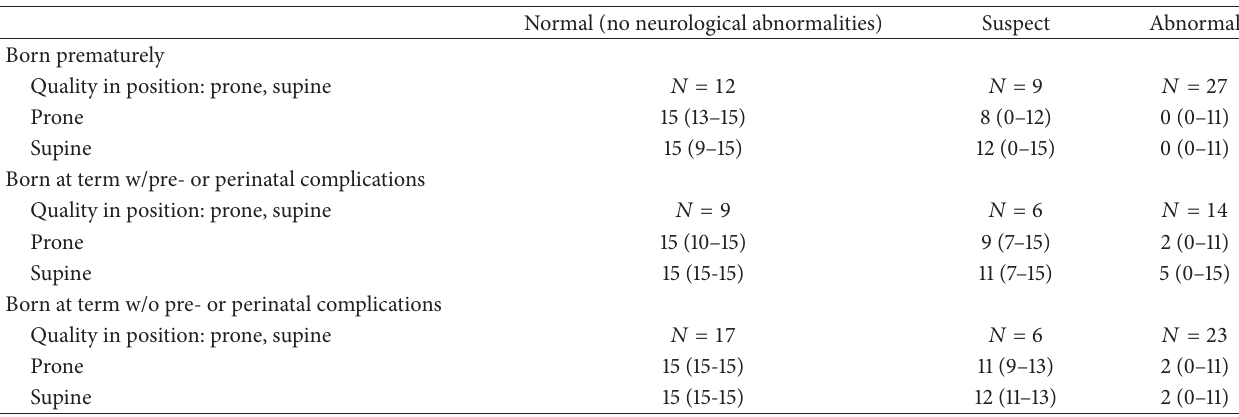
Table 3: Qualitative assessment score (maximum of 15) at 3 months, performed by a physiotherapist; data reported according to gestational age and neurological assessment. Results are given as median (quartiles